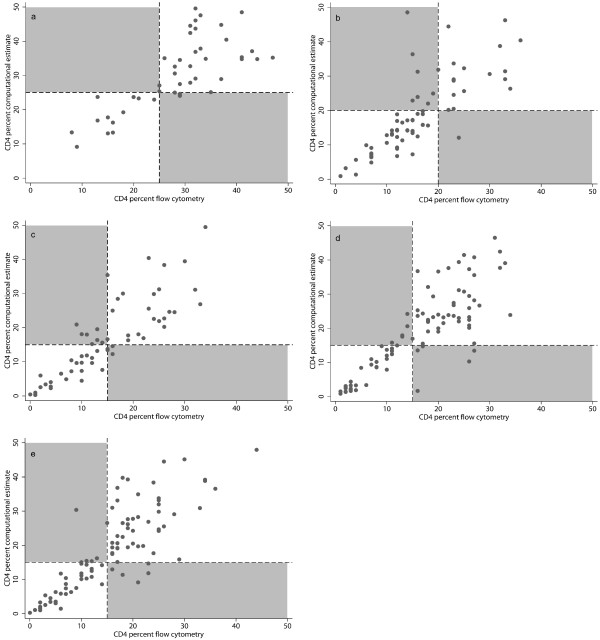
CD4 percent obtained by flow cytometry and computational estimate by age group: (A) 0 to 11 months, (B) 12 to 35 months, (C) 36 to 59 months, (D) 60 to 95 months (E) more than 95 months. Grey areas indicate children misclassified using CD4 percent computational estimate compared to CD4 percent obtained by flow cytometry.